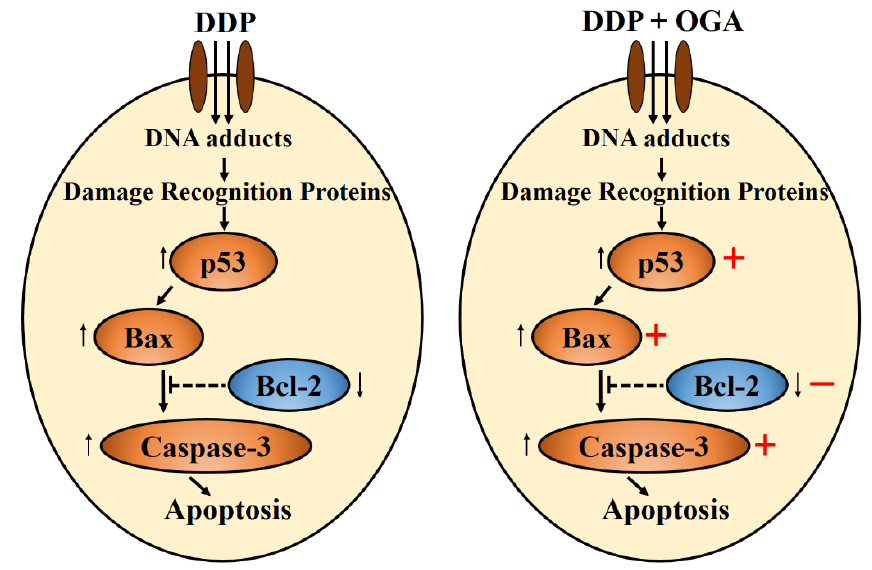
Figure 6. Schematic diagram of the synergistic effect of OGA on DDP-induced apoptosis in human lung cancer A549 cells. DDP: cisplatin, OGA: oligogalacturonides.